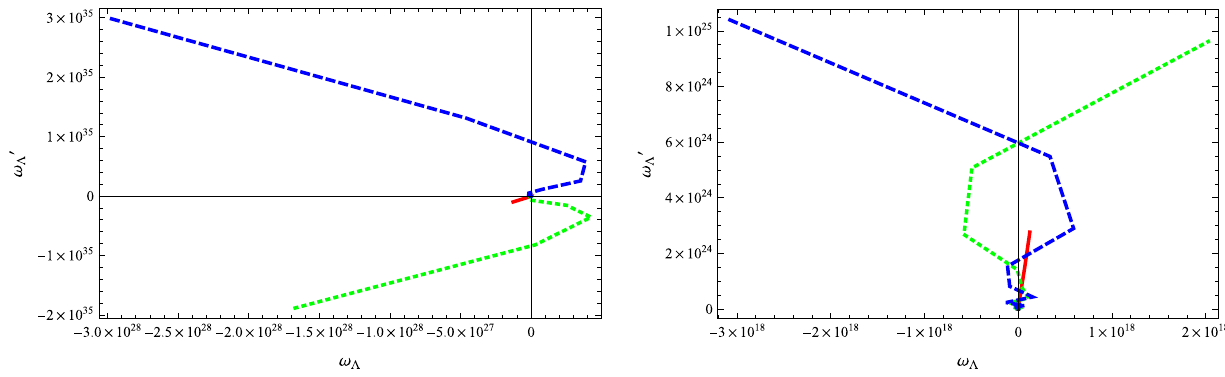
Fig. 13 Plots of unified phases ω (cid:3) − ω (cid:2) (cid:3) for u = 2 (left) and − 2 (right). Also, H 2 = 2 . 7 (red), H 2 = 2 . 75 (green) and H 2 = 2 . 8 (blue)